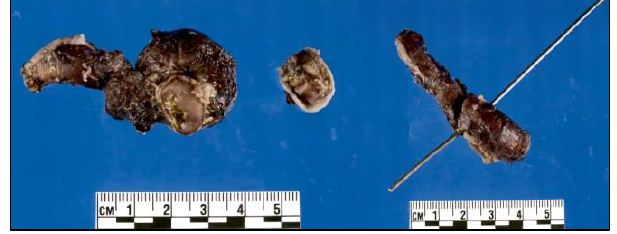
Figure 1: Pathologic specimen showing the perforated Meckel’s diverticulum that was surgically removed from our patient. Postoperatively, we continued an oral gastric tube for 8 days. He began having bowel function and tolerat- ing feedings by the 10th postoperative day. He re- mained in the NICU to wean oxygen requirements and ensure tolerance of oral feedings and we discharged him from the hospital at 22 weeks of